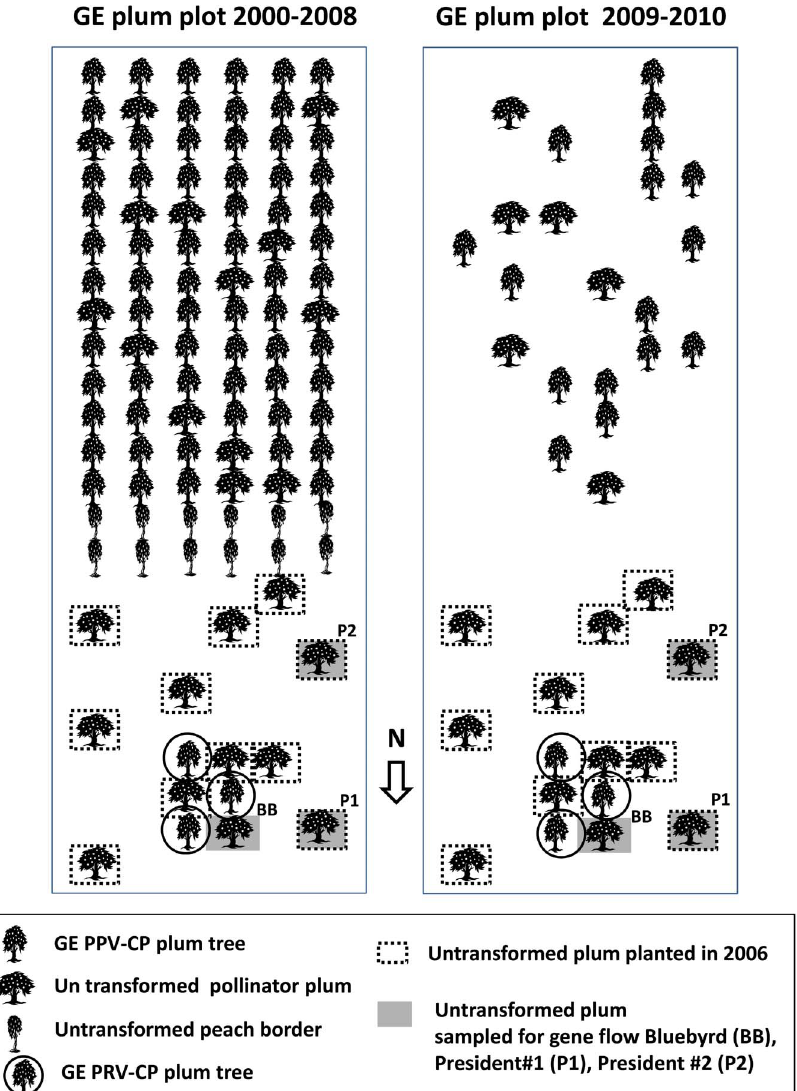
Figure 1. Plot T0 source block for gene flow from genetically engineered (GE) plum trees.